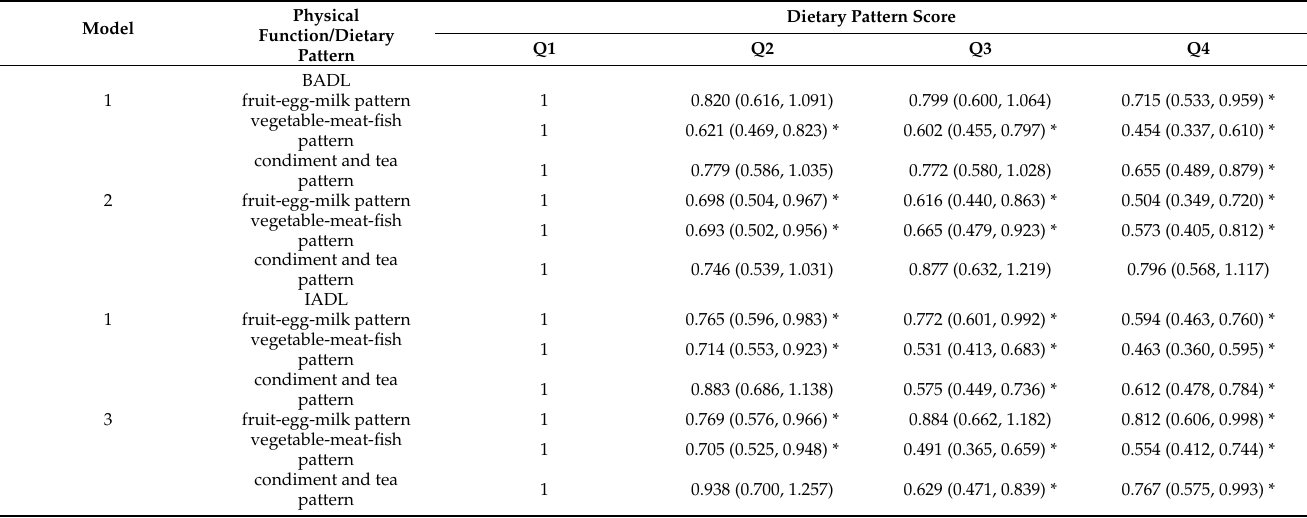
Table 5. Logistic regression analysis between dietary pattern score and physical function ( n =